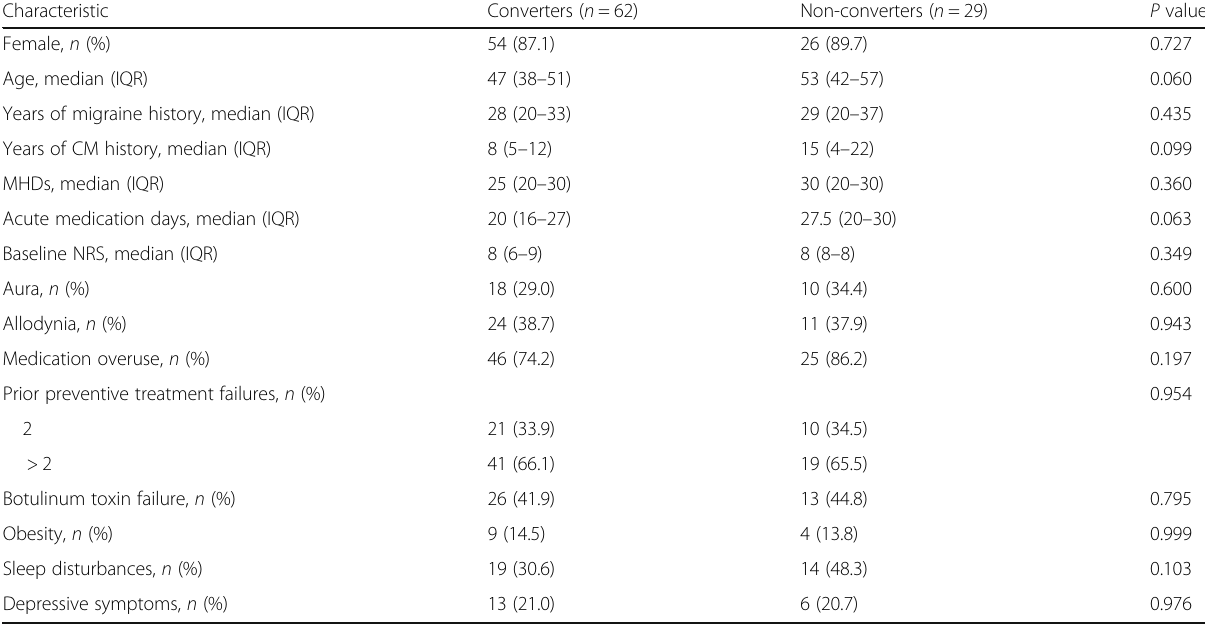
Table 2 Baseline characteristics of converters versus non-converters to episodic migraine during the treatment